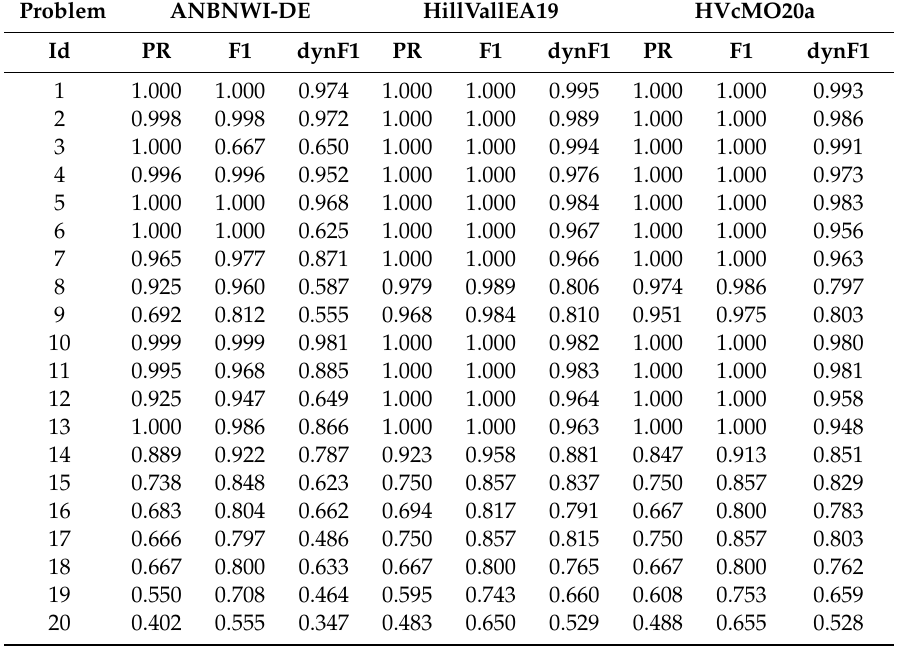
Table A1. Mean values measured over 50 runs by ANBNWI-DE, HillVallEA19 and HVcMO20a for each test problem, assessed at all levels of